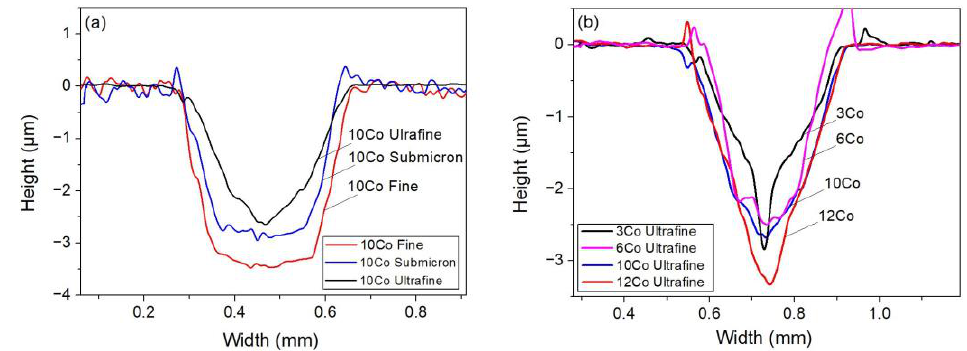
Figure 10. Cross-sectional profiles of the wear traces of the coated cemented carbides: ( a ) M1, M3, M6; ( b ) M4, M5, M6, M7.